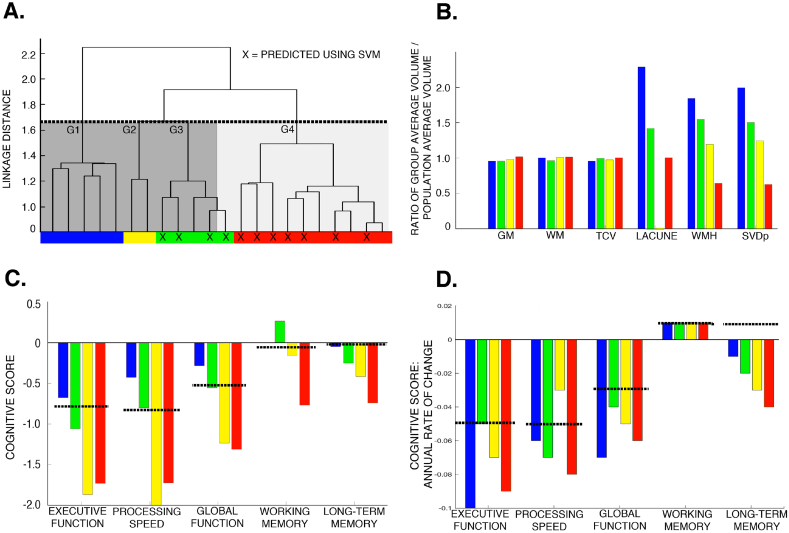
Anatomical subgroups in the preclinical dementia cohort. A) Dendrogram generated using ward-linkage on the unrepaired Jacobian determinant images. Dashed line shows the cut-off used to identify the four subgroups. The successful support vector machine predictions are shown (X), and the level of vascular damage indicated (dark grey - SVDp >4%; light grey – SVDp <4%). B) Differences in the MRI parameters between the identified sub-groups. These have been normalised by the population average to allow all parameters to be shown on a single plot. C) Differences in the cognitive parameters between the identified sub-groups, dashed line indicates population average. D) Differences in the rate of change in the cognitive profile, dashed line indicates population average.